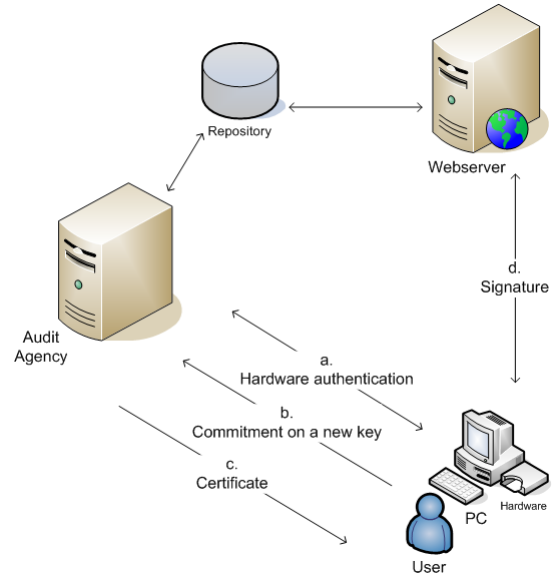
Figure 3. Anonymous Attestation Via User